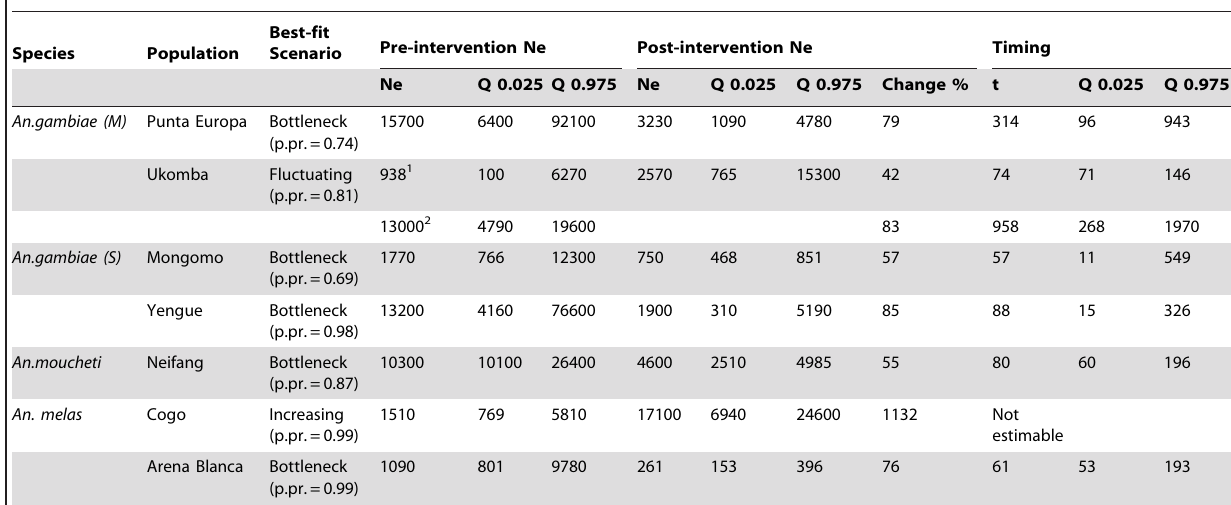
Table 4. Results from ABC analysis for each sampled population—showing best-fit scenario, pre-intervention N e (with 0.025 and 0.975 quantiles), post intervention N e (with quantiles), and the timing of a population change (generations before present), t (with quantiles), and percentage change in N e . Medians are reported for all